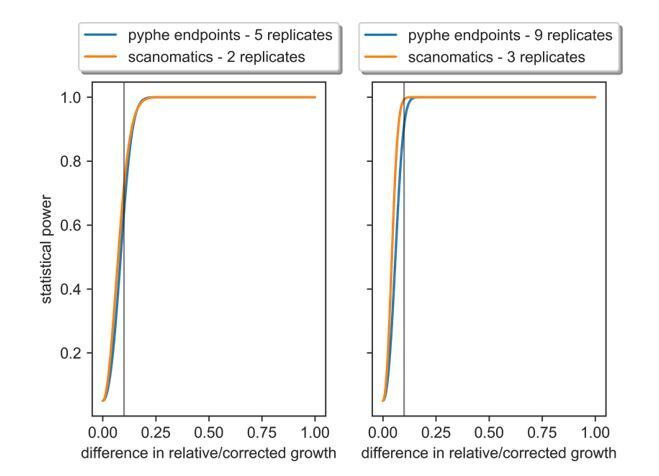
The analysis shows the number of replicates required with scan-o-matics and with pyphe in order to achieve the same statistical power.